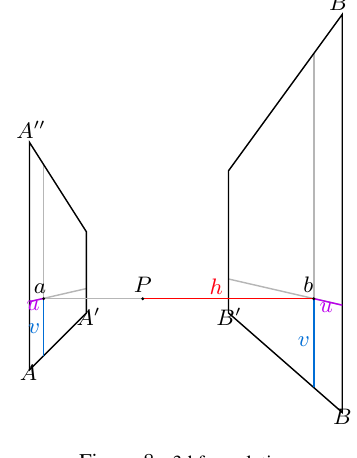
Figure 8: 3d formulation −−→ ⊥−−→ −−→ ⊥−−−→ 3d formulation. As in figure 8, AA 0 AA 00 and BB 0 BB 00 . Figure 10: Laser beams (a). Surface reconstructed in a Cartesian coordinate system (b) and a prismatic coordinate system (c). The use of Cartesian coordinate system may leads to a surface that ”goes through” the wall because it is attracted by points of the room ceiling behind the facade (1). The surface is also attracted to a wall light (2). The surface reconstructed using the prismatic coordinate system follows the beam trajectory, it goes trough the window (1) and wraps the wall light